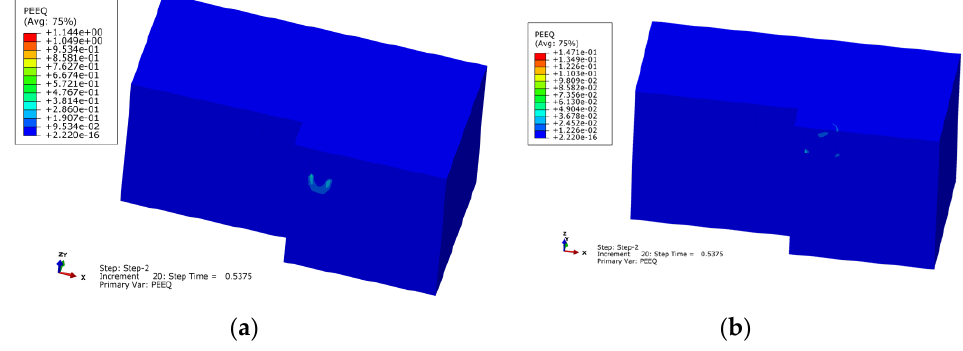
Figure 20. Soil equivalent plastic strain contours at the 1# and 2# bucket central section for the TSPJF and TBJF under the ultimate overturning moment. ( a ) TSPJF, ( b ) TBJF.